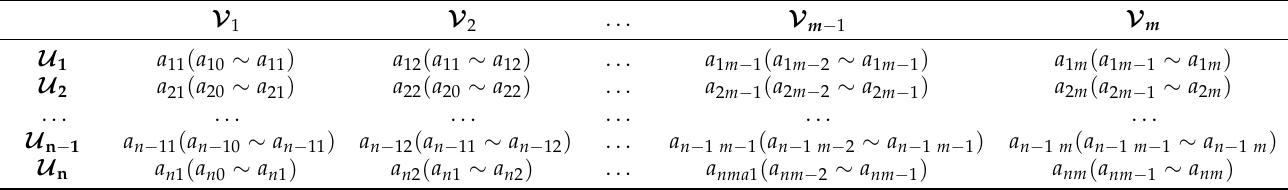
Table 5. The set of evaluation factors and the set of appraisal